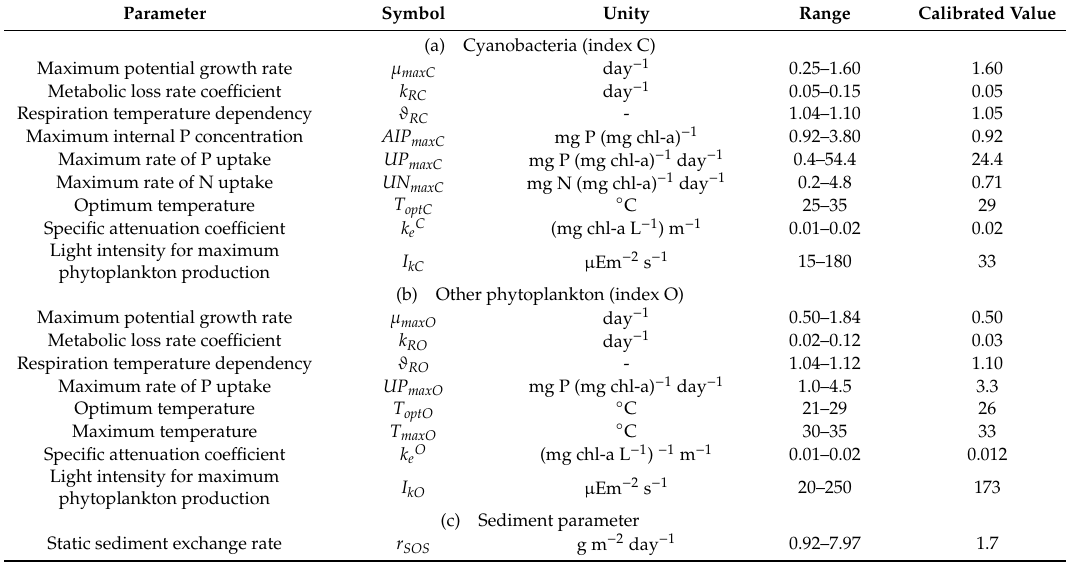
Table A6. Range of parameter values used in the calibration of phytoplankton modelling parameter calibrated